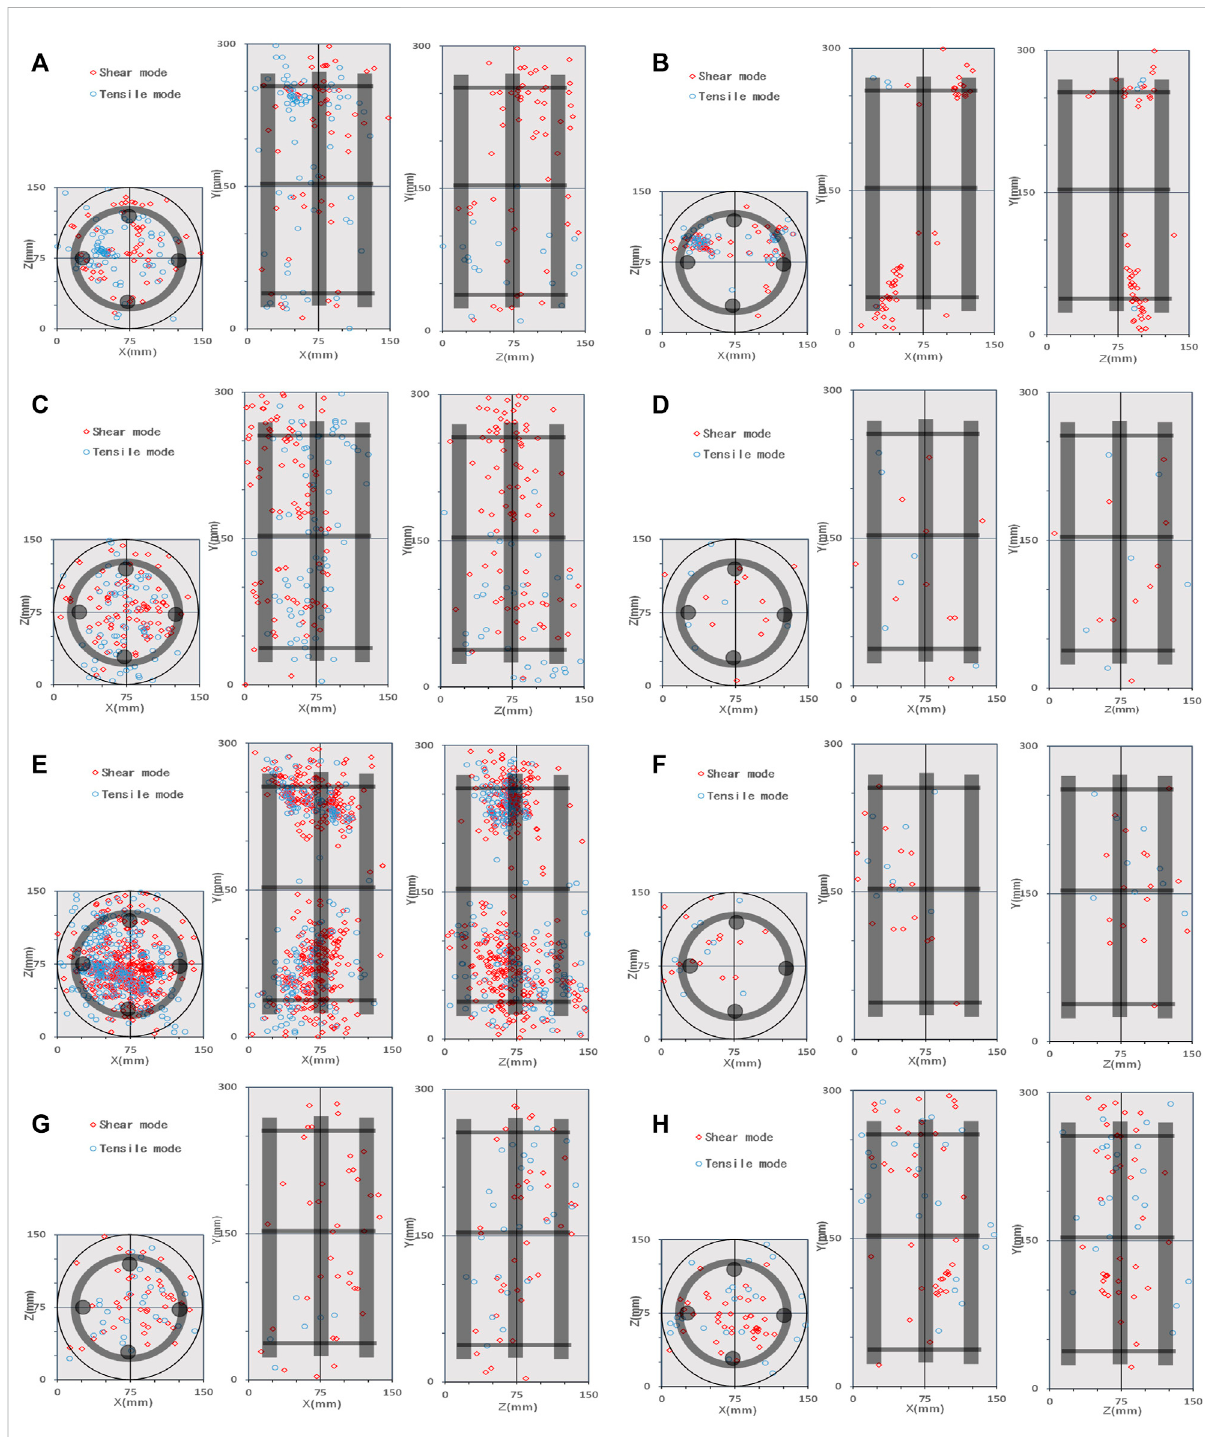
FIGURE 17 SiGMAanalysisforAEsources3Dpositioning (A) Healthyconditioninuncoatedcase. (B) Initiationstageinuncoatedcase. (C) Accelerationstage in uncoated case. (D) Deterioration stage in uncoated case. (E) Healthy condition in coated case (F) Initiation stage in coated case. (G) Acceleration stage in coated case. (H) Deterioration stage in coated